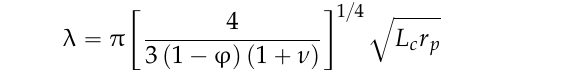
Figure 4. Behaviour of a drop coated with particles as the drop volume is reduced [60]. The pressure inside the drop increases slightly for only small reductions in the drop volume (Regime I). The interface remains fluid ‐ like and the drop profile shrinks isotropically. In Regime II, the particles pack closely together and jam. The pressure inside the drop falls to zero and the drop takes on the shape of a wrinkled hemisphere. At even larger reductions in drop volume (Regime III), the pressure is insensitive to the compression. The particle layer coating the drop buckles and flattens at the top of the drop.